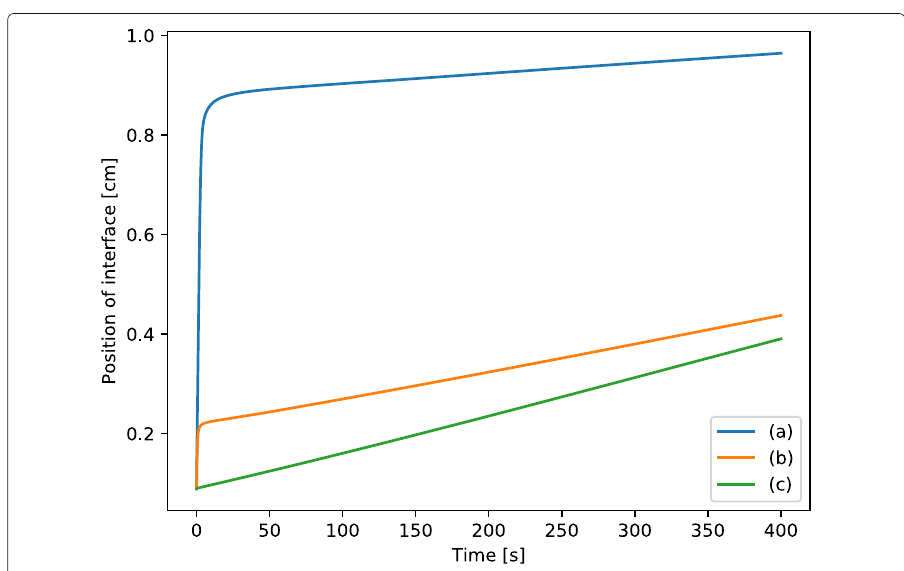
Fig. 5 Interface position as a function of time for case (a), (b) and (c) from Fig.